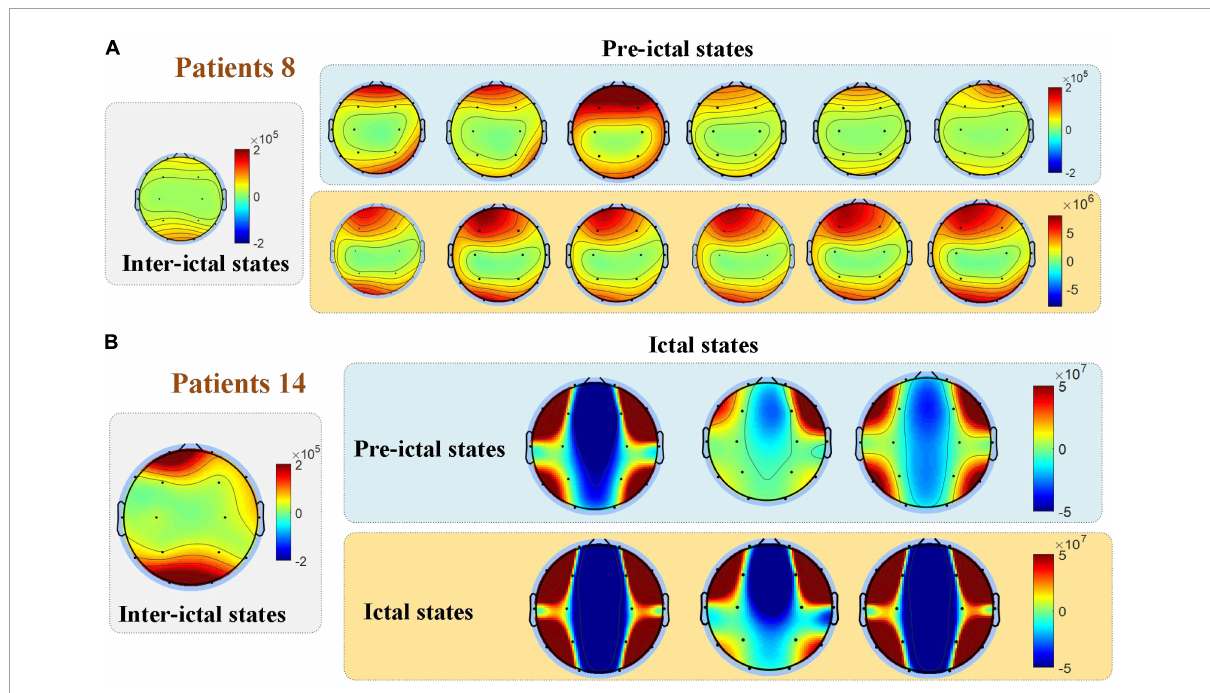
FIGURE6 Comparisons among the three groups in the spatial distribution of EEG power. The spatial distribution of EEG PSD varies among individuals, while most patients have a similar spatial distribution of multiple consecutive seizures as shown in (A) . (B) For some patients, the spatial distribution of the pre-ictal state showed similarities to the ictal